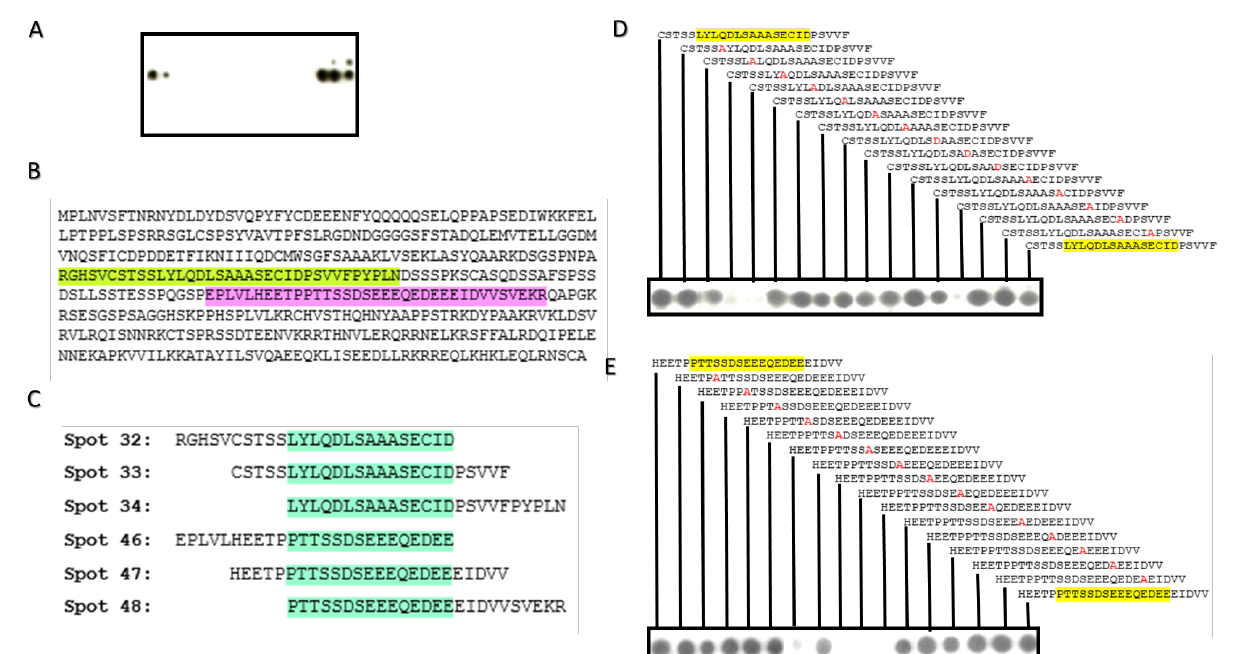
Figure 5. Physical mapping of c-MYC for USP 37 interaction. ( A ) Peptide array of c-MYC protein probed with USP37 showing binding of the protein with the 25 mers spots (32–34 and 46–48) of c-MYC. ( B ) Protein sequence of c-MYC showing regions corresponding to spots 32–34 (highlighted lime green) and spots 46–48 (highlighted fuchsia pink). ( C ) Peptide sequence spotted on each binding spots with consensus regions highlighted aqua). Alanine scan array of consensus sequence (highlighted yellow) in ( D ) spot 33 and ( E ) spot 47 of c-MYC. Black dots showing effective binding of the c-MYC peptide with USP37, whereas lighter or absence of the dots represent weak or absent binding due to the substitution of the residue with alanine/aspartic acid (red colored) in c-MYC alanine array.